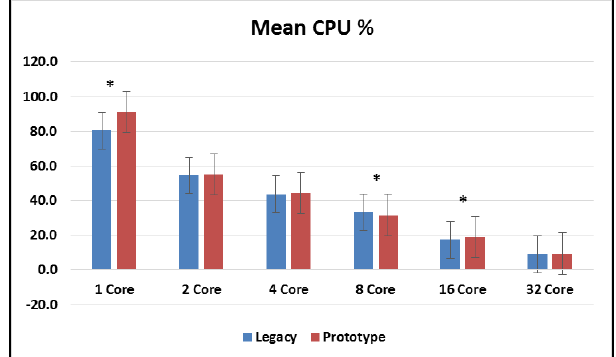
Figure 4: Mean Performance Comparison between Servers We discovered significant performance differences between the two server configurations when allocated 1, 8 and 16 cores. No performance differences were found between the server configurations when allocated 2, 4 and 32 cores. We attribute the difference in Host CPU % to the varying minimum degradation load between each server and instead focus our analysis on the trend comparison observed with both server